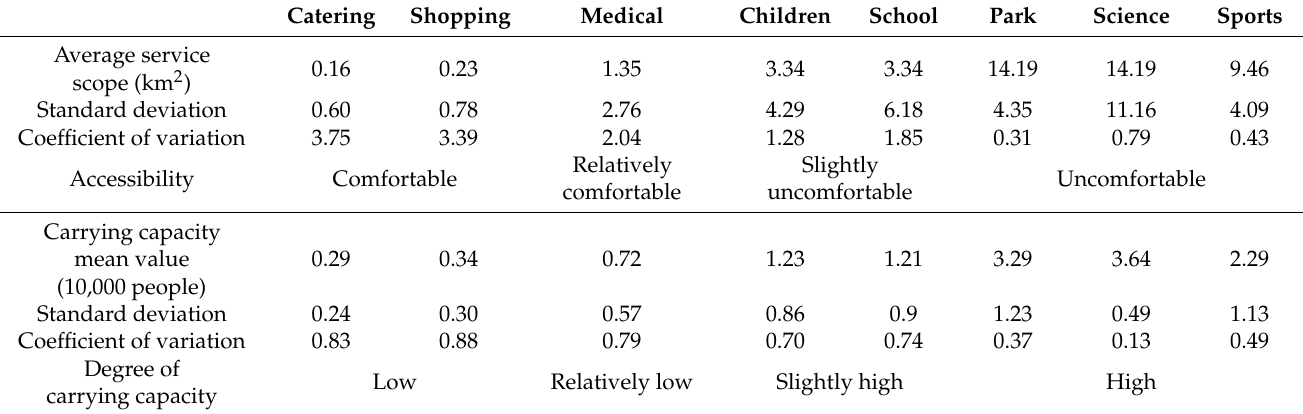
Table 5. Evaluation results for the public service facilities in the Chenglingji new port area.